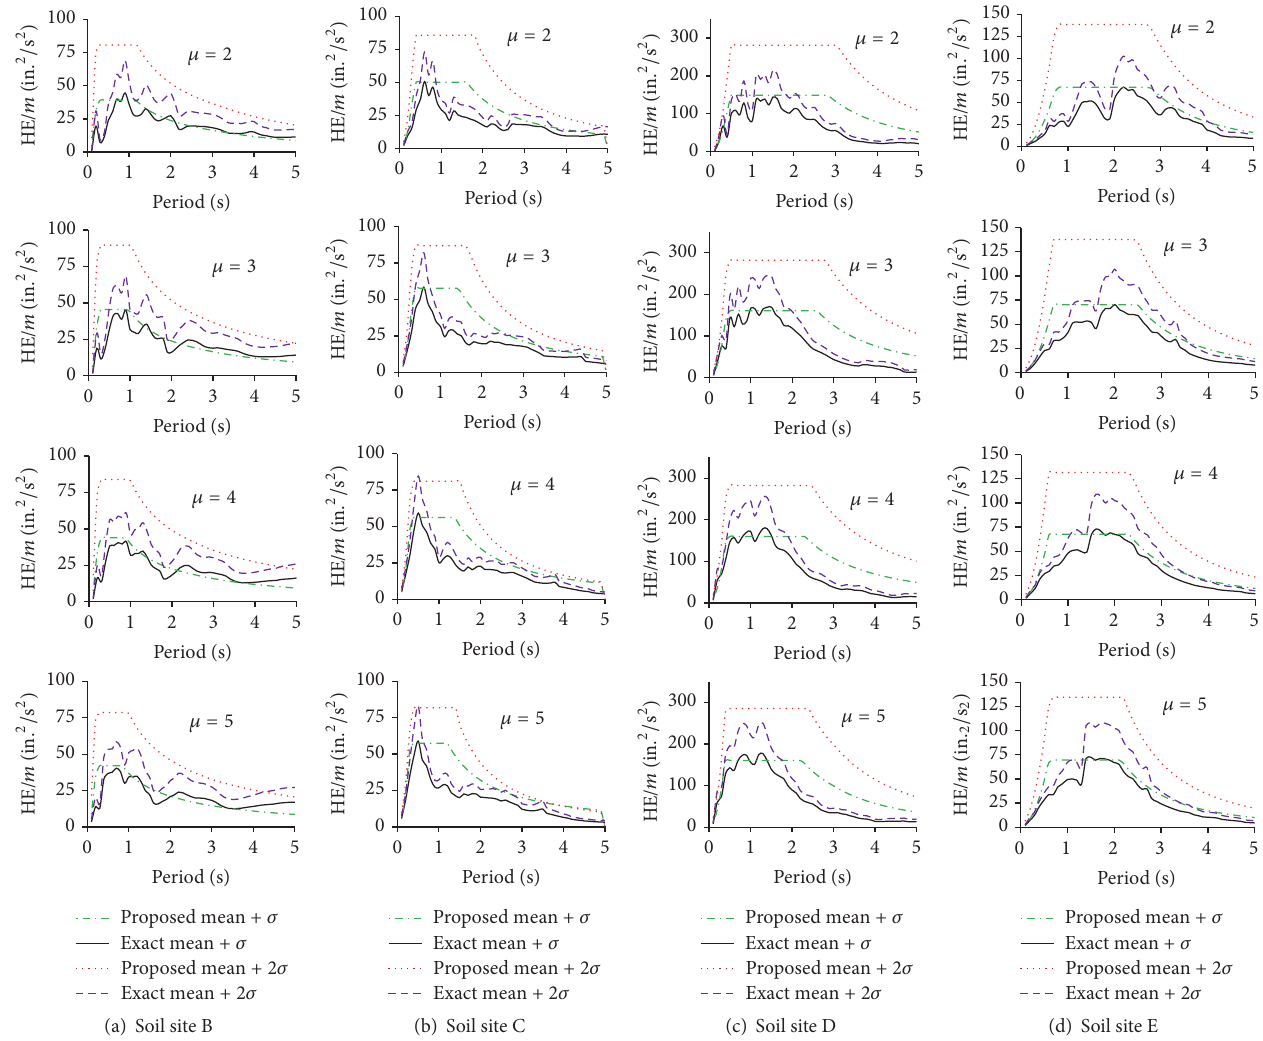
Figure 15: Comparative study of proposed hysteretic energy spectra: hysteresis model BF.